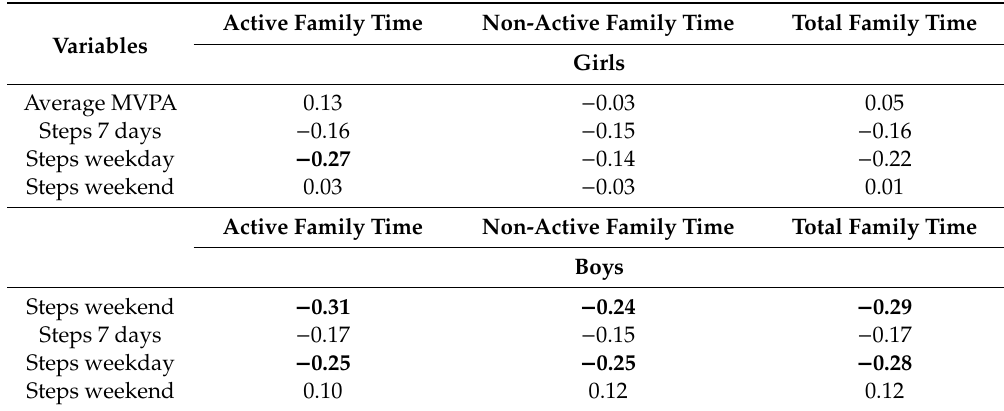
Table 4. The Spearman correlation coe ffi cients ( r ) between variables: active family time, non-active family time, total family time and weekday, steps during the weekend and MVPA in